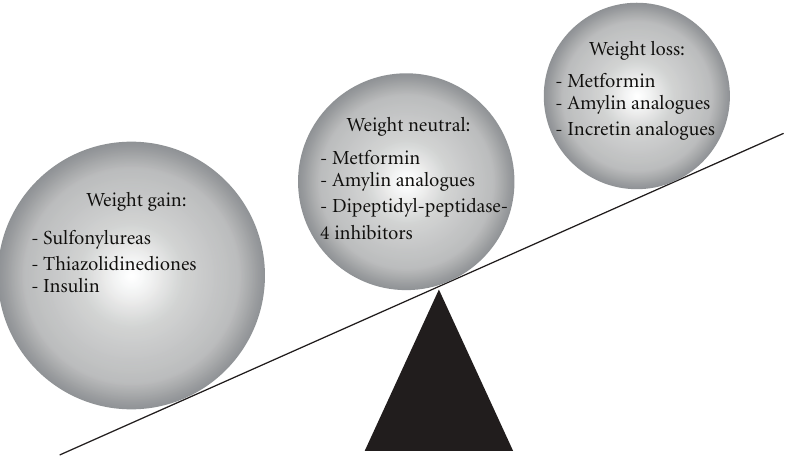
Figure 1: E ff ects of various antidiabetes agents on body